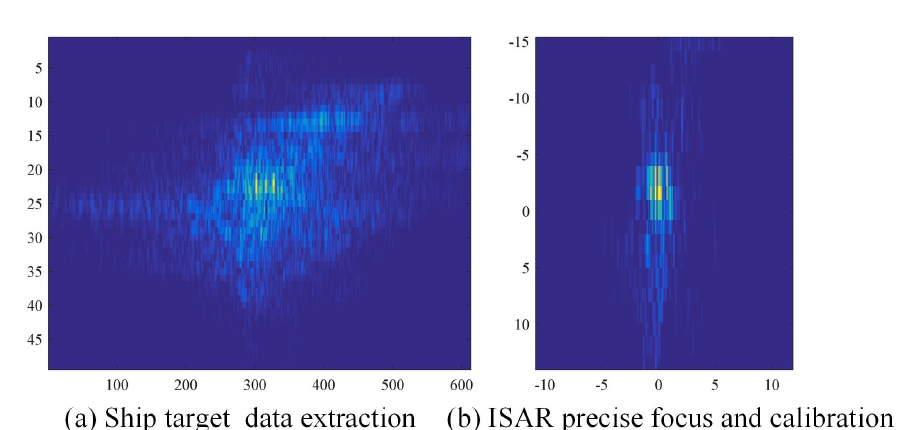
Figure 19. Ship target data extraction and fine focusing